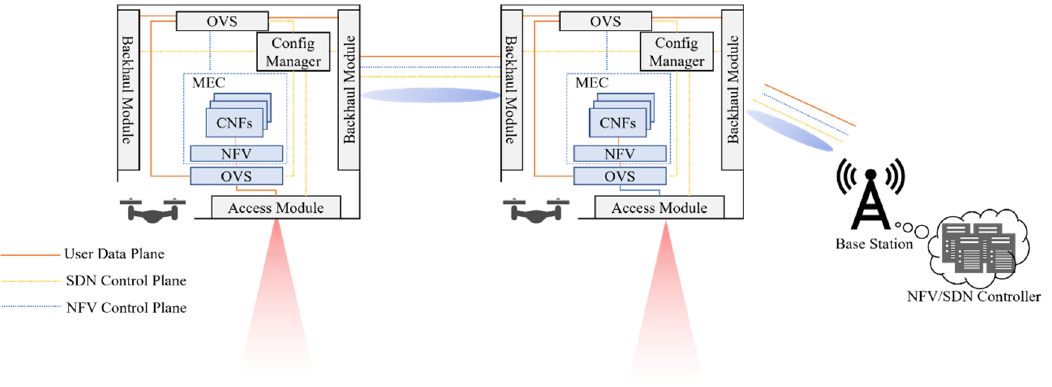
Figure 6. Dynamic control NFV/SDN-assisted UAV networks.